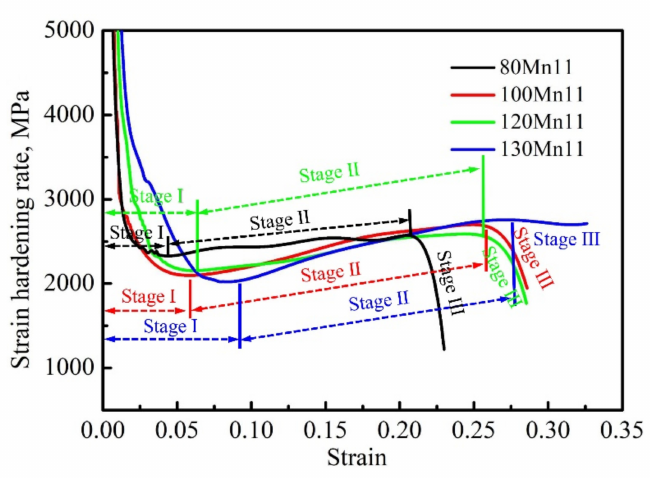
Figure 2. Strain hardening curves of test